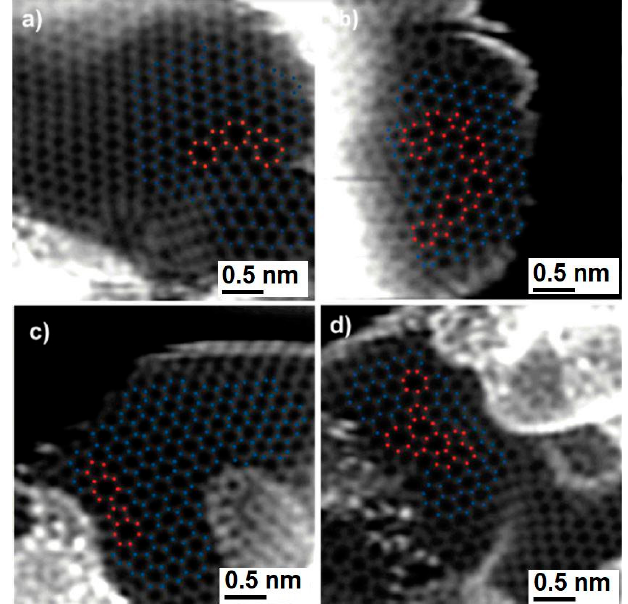
Figure 23. ( a , b ) STEM images of wood-based and ( c , d ) polyfurfuryl alcohol-based nanoporous carbons. Hexagonal carbon rings are marked in blue, five- and seven-membered rings are marked in red. Reproduced with permission from Guo et al. [92]. Copyright John Wiley and Sons, 2012.